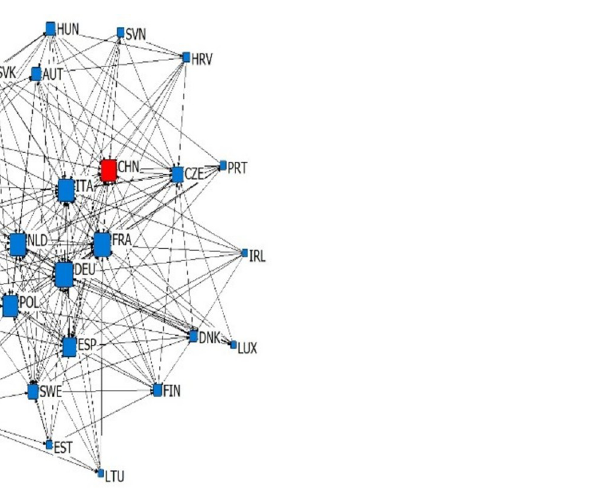
Fig 3. Upper vertical intra industry export dependence network.